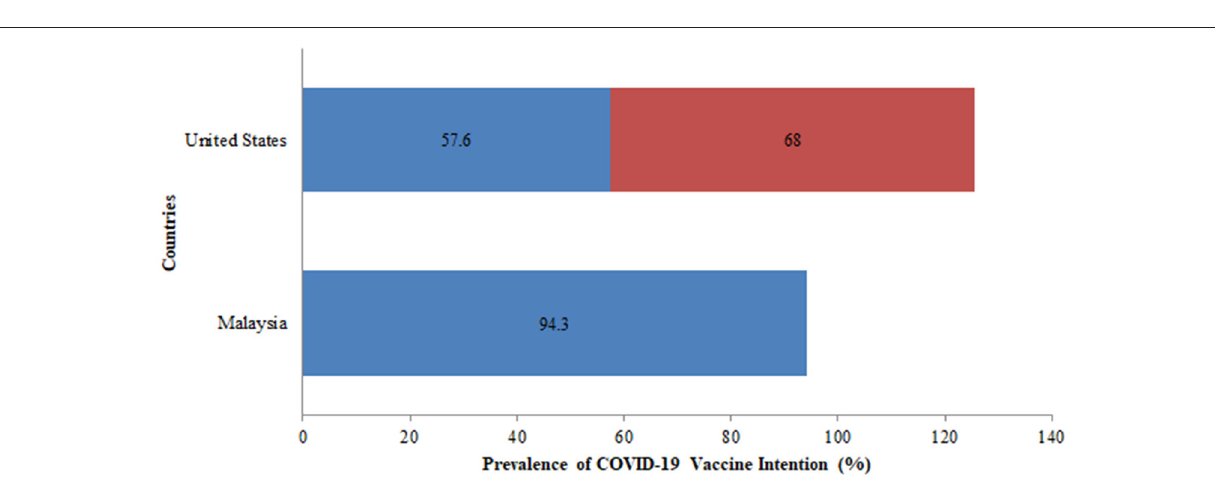
nation’s population, length of vaccine testing. Few concerns of parents/caregivers regarding COVID-19 were a novelty and rapid development of the vaccine, child not perceived to be at risk to contract COVID-19, side effects/safety concerns, and efficacy